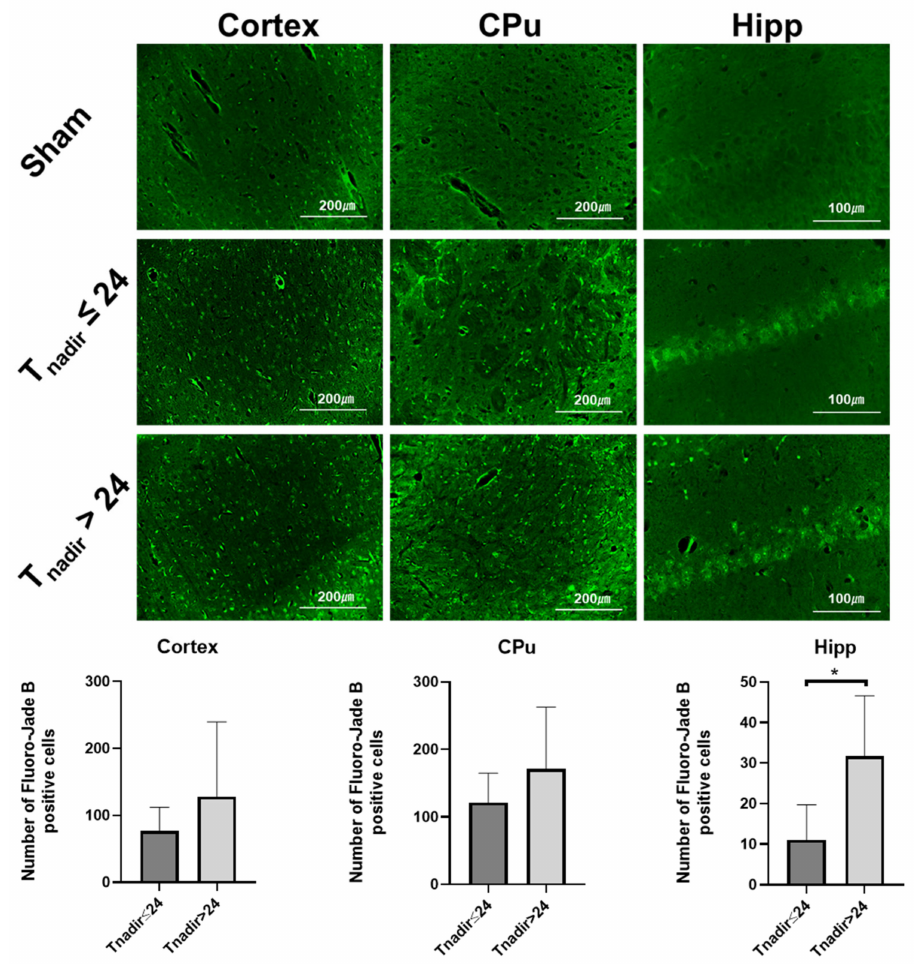
Figure 9. Fluoro-Jade B (FJB) immunostaining in the cortex, caudoputamen, and hippocampus. (Upper) Representative photomicrographs of brain sections (cortex, caudoputamen (CPu), and hippocampus (Hipp) CA1 region), showing FJB-positive cells in sham-operated rats and post-cardiac arrest rats having T nadir ≤ 24 min and Tnadir > 24 min. (Lower) Number of FJB-positive cells in the cortex, caudoputamen, and hippocampus regions in survived rats having T nadir ≤ 24 min ( n = 9) and Tnadir > 24 min ( n = 6). Data are presented as mean ± SD. * p <